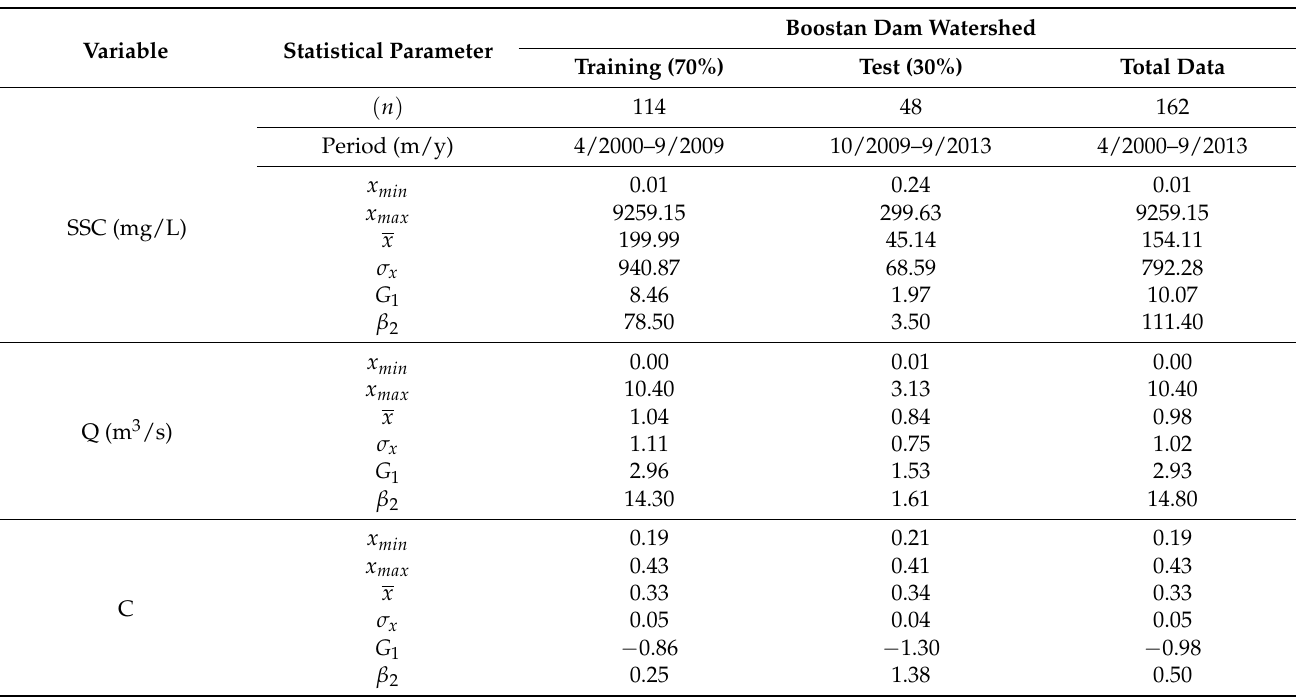
Table 1. Statistical parameters of monthly SSC, discharge, and C-factor for the Boostan Dam Watershed 1